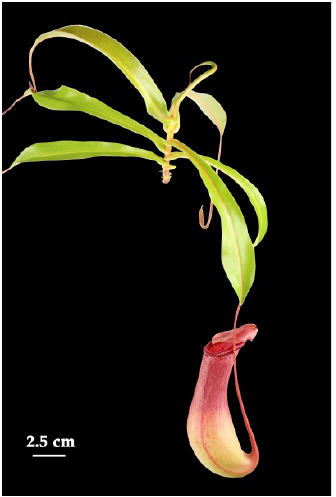
Figure 1. Nepenthes x ventrata . Natural hybrid of N. ventricosa and N. alata .